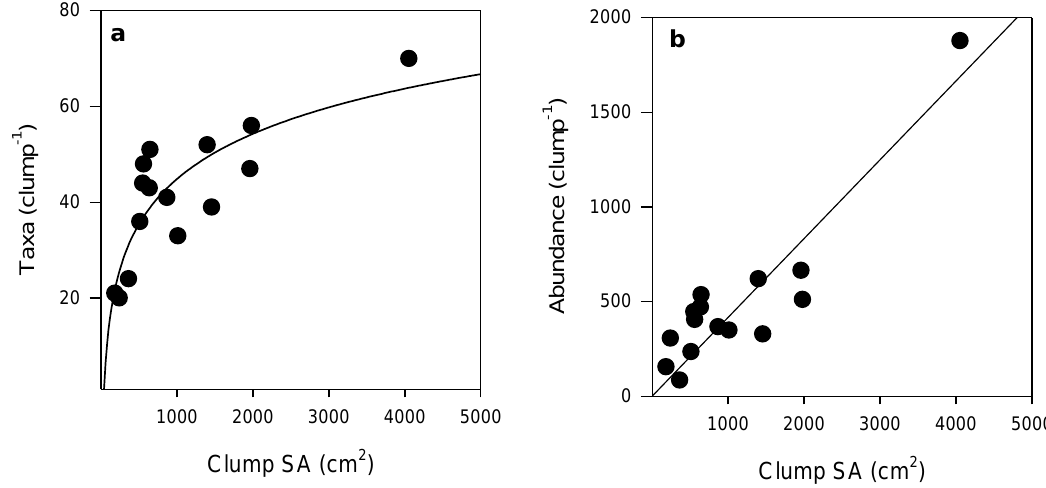
Figure 2. ( a ) Number of taxa (logarithmic curve fit, R 2 = 0.68, n = 15) and ( b ) abundance of epifaunal communities (linear regression R 2 = 0.82, n = 15) associated with Sabella clumps with increasing surface area (SA). See Table S2 for further curve fit detail.